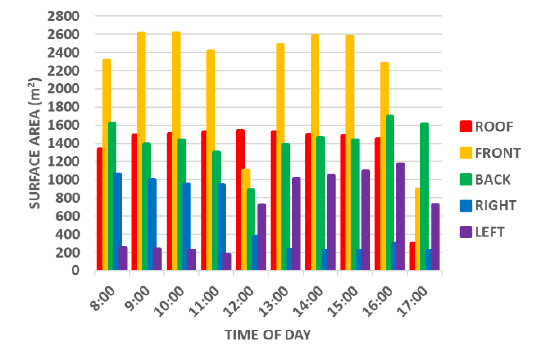
Figure 17. Hourly - Surface Receiving Radiation (2017) From 8:00 to 16:00 all through-out the year average values of solar irradiation on the roof almost remain at a constant value, this can be brought on by the limitation of the roofs area. It can be shown from Figure 17 that all through-out the day the roof almost fully receives solar radiation. For the back and the roof, solar irradiation values peaks at the middle of 8:00 to 12:00 and 12:00 to 16:00 and reaches its minimum at 12:00. For the right